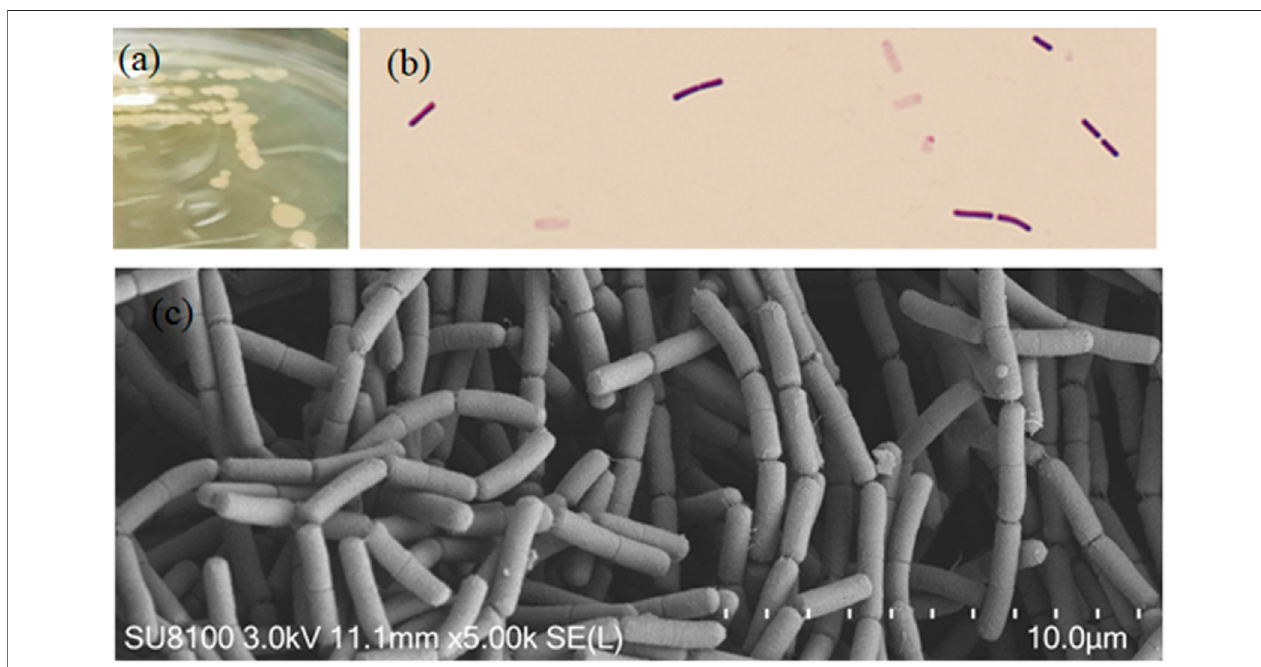
FIGURE1| ThemorphologiesofthestrainEM-A1.ColonyonLBplates (A) ,gramstainingreactionbyopticalmicroscope (B) ,andcellsunderthescanningelectron microscope (C) .